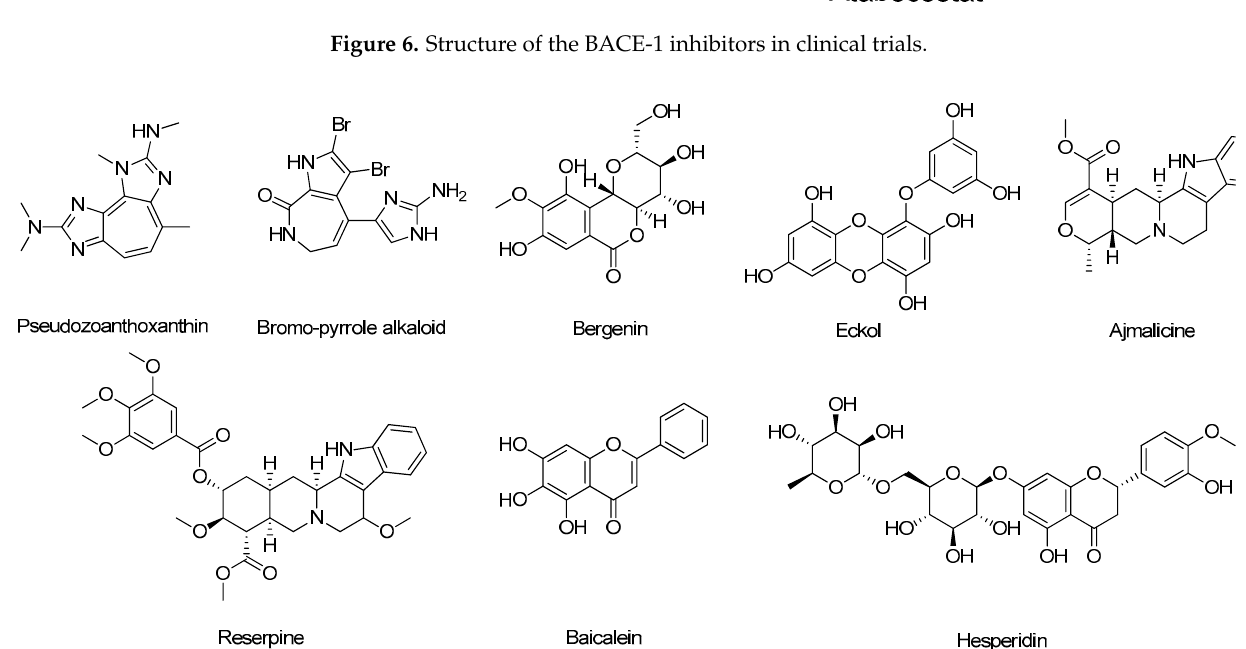
Figure 7. Structures of the studied BACE-1 inhibitors.